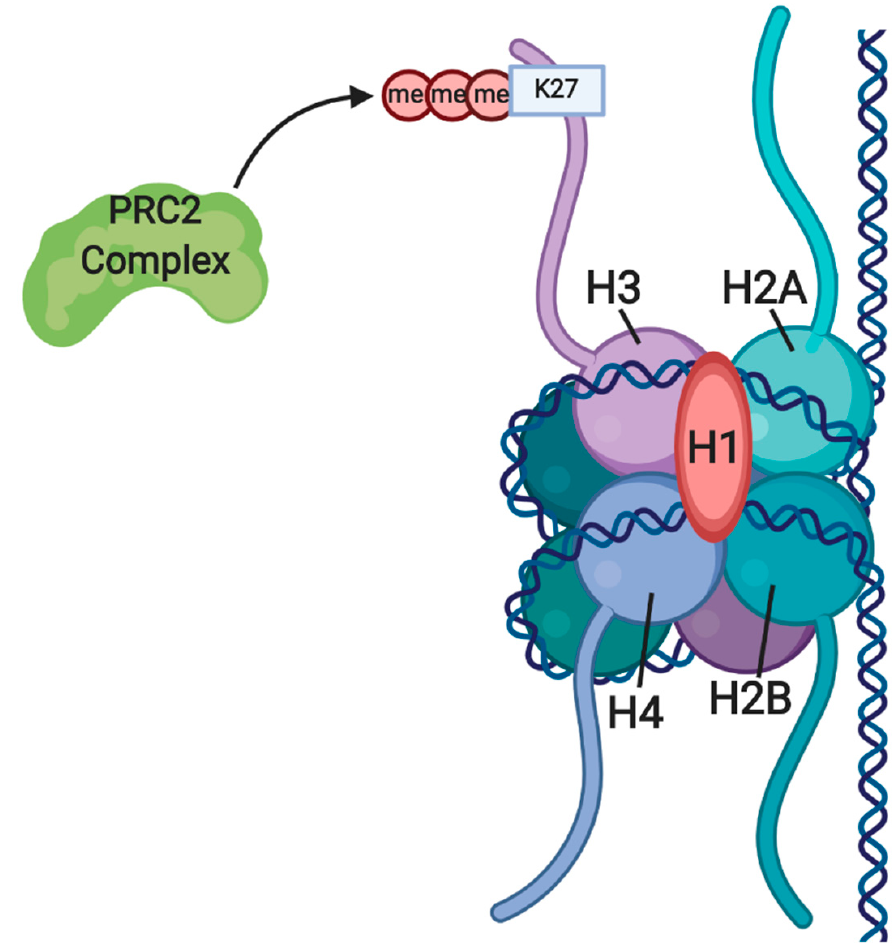
Figure 1. Structure of the nucleosome, with modification of histone tails. Histones bind together in an octamer structure to create the nucleosome around which the DNA strand wraps itself. Tail sections of the histones extend from the structure and are subject to post-translational modifications such as acetylation, methylation and phosphorylation. The repressive trimethylation mark of H3K27me3 and the PRC2 protein complex responsible for the modification are shown [1].